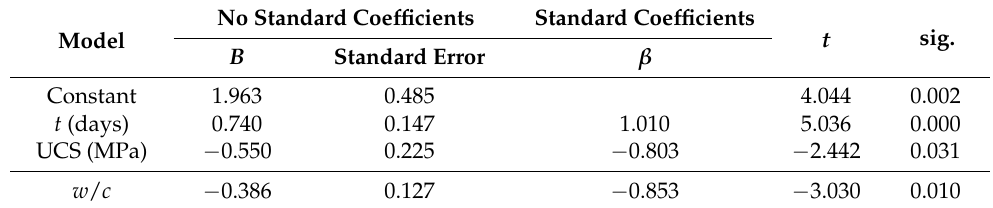
Table 15. Determination coefficients for strain model of CDWRCer. Dependent variable: